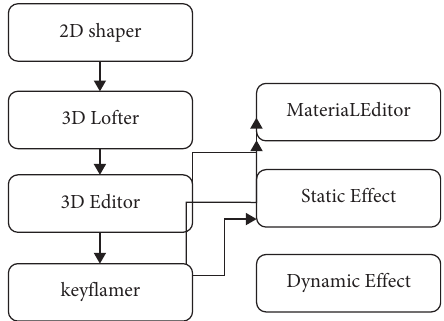
Figure 3: Workflow chart of Dstudio.